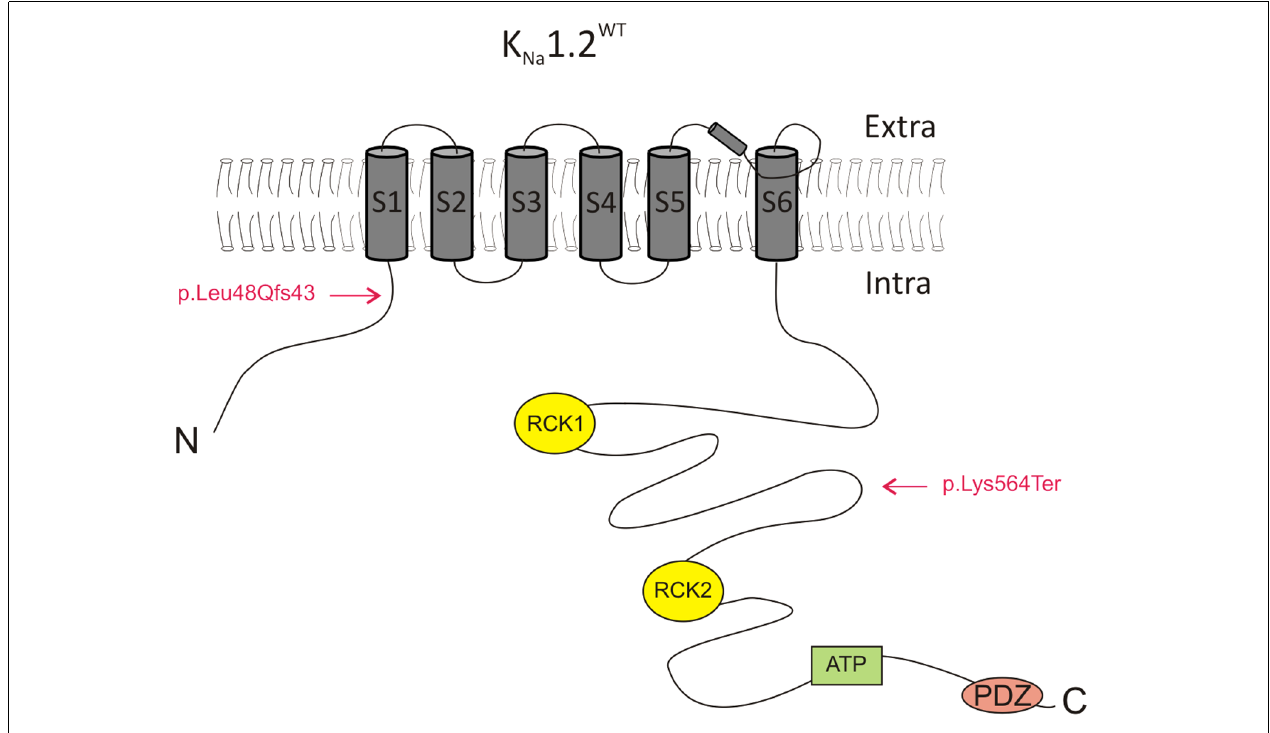
FIGURE 1 | Schematic representation of the K Na 1.2 subunit. The location of the two mutations identified in the present study (p.K564 ∗ and p.L48Qfs43) is indicated. ATP, adenosine triphosphate binding domain; Extra, extracellular milieu; Intra, intracellular milieu. RCK1 and RCK2, regulator of conductance of K + domains 1 and 2.